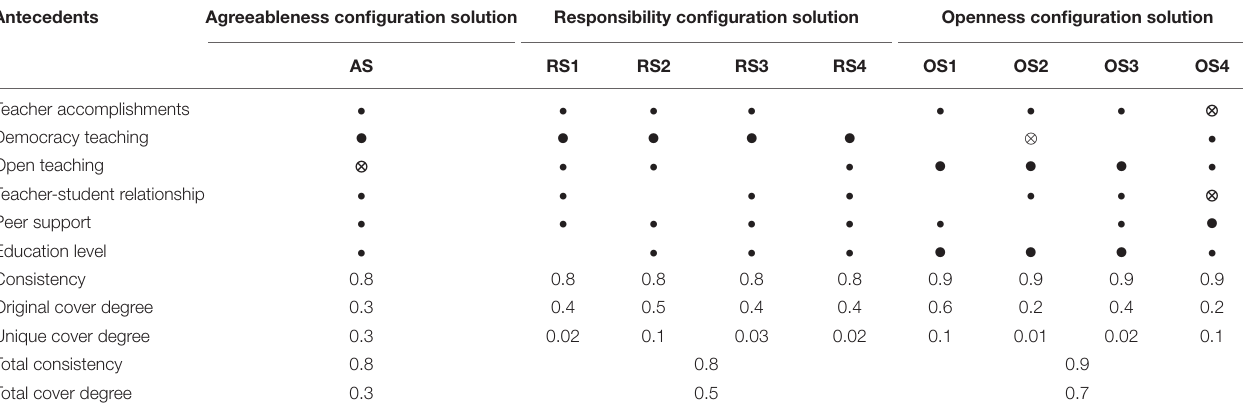
TABLE 6 | Matching analysis of school experience and high original innovation personality.